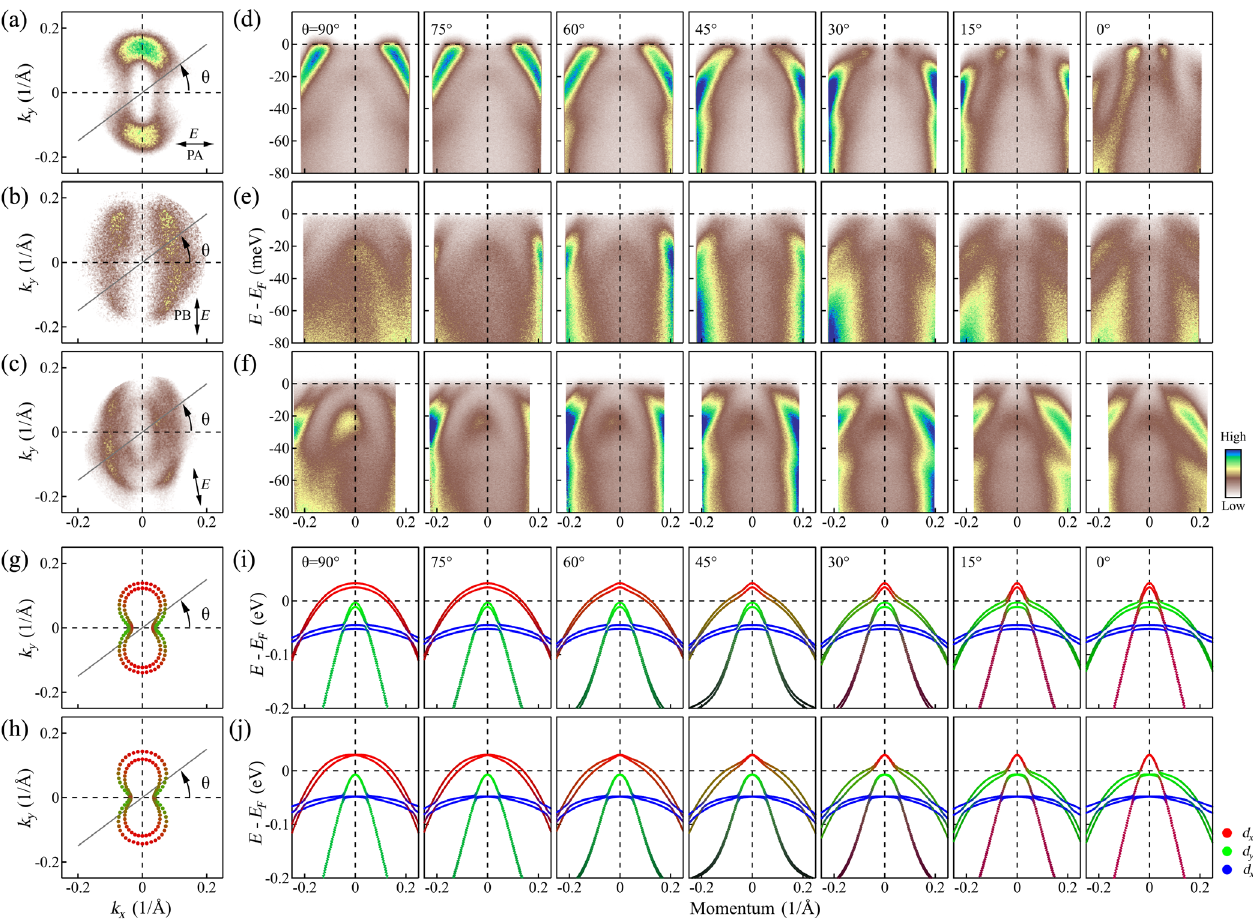
FIG. 4. Calculated Fermi surface and band structure of FeSe and their comparison with the measured results. (a) – (c) The Fermi surface mappings of the single-domain FeSe measured under the PA (a), the PB (b), and a mixed (c) polarization geometries. The momentum cuts here are defined by the Fermi surface angle θ . (d) – (f) Band structure for the momentum cuts at different Fermi surface angles θ corresponding to (a) – (c). (g),(h) Calculated Fermi surface around Γ point in considering the ferromagnetic order and the Rashba spin- orbit coupling in the nematic state of FeSe, respectively. Their corresponding band structures are shown in (i),(j). The d xz , d yz , and d xy orbital components are represented by red, green, and blue colors,